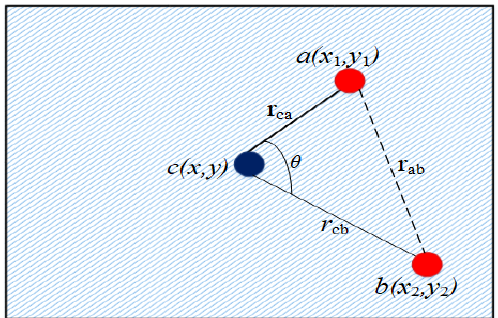
Figure 2. Angle between identical visual word pairs with respect to the